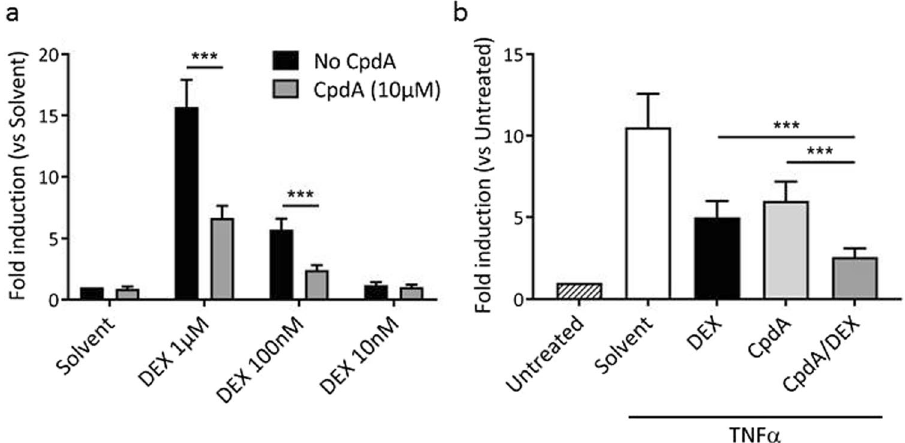
Figure 1. Combining DEX with CpdA enhances the repression of an NF- κ B-dependent reporter and reduces the transactivation activity on a GRE-dependent reporter. ( a ) L929sA cells with a stably integrated p(GRE) 2 - 50-luc + , a GRE-dependent promoter construct, were pre-incubated with CpdA (10 µ M) for 1 h, after which three different concentrations of DEX (10 − 6 M, 10 − 7 M and 10 − 8 M) were added for 5 h. Promoter activities are expressed as relative induction factor versus Solvent/No CpdA. Four independent replicates were performed. Means + SE, obtained as predictions from the HGLMM fitted to the data, are shown on the original scale. ( b ) L929sA cells with a stably integrated p(IL6- κ B) 3 -50hu.IL6P-luc + , a NF- κ B-dependent promoter construct, were sequentially stimulated with CpdA (10 µ M for 6 h), DEX (1 µ M for 5 h) and TNF α (2000 units/ml for 4 h) with 1 h between stimulations. Promoter activities are expressed as relative induction factor versus Untreated. Five independent replicates were performed. Means + SE, obtained as predictions from the HGLMM fitted to the data, are shown on the original scale. The significance of ligand combination effects on reporter activity, estimated as differences (on the transformed scale) to the reference level CpdA/DEX, were assessed using a t-test ( * p < 0.05; ** p < 0.01; *** p <